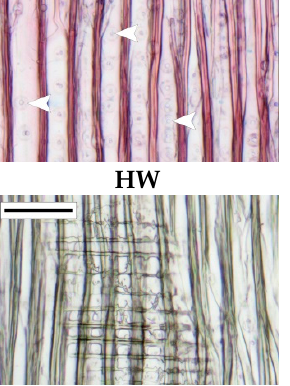
Figure 5. Representative images of four consecutive tree rings of a core sampled at a height of 1.5 m from the model tree in SP 2, Blueberry pine forest, 80 years. HW—heartwood, TZ—transition zone, SW—sapwood. Scale bar = 100 μ m. Other designations are the same as in Figure 4.